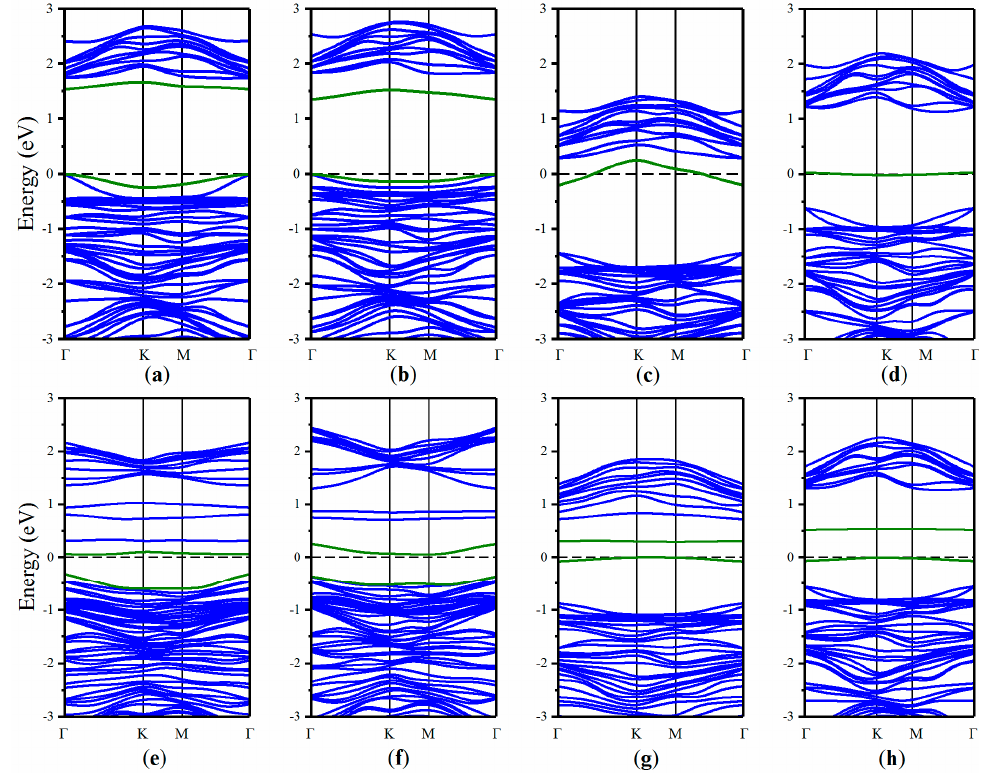
Figure 4. Band structures of ( a ) Al-, ( b ) B-, ( c ) S- and ( d ) Si-doped arsenene As 31 X systems, as well as NO adsorbed on ( e ) As 31 Al, ( f ) As 31 B, ( g ) As 31 S and ( h ) As 31 Si monolayers, respectively. The Fermi level is set to zero with the black dashed line.